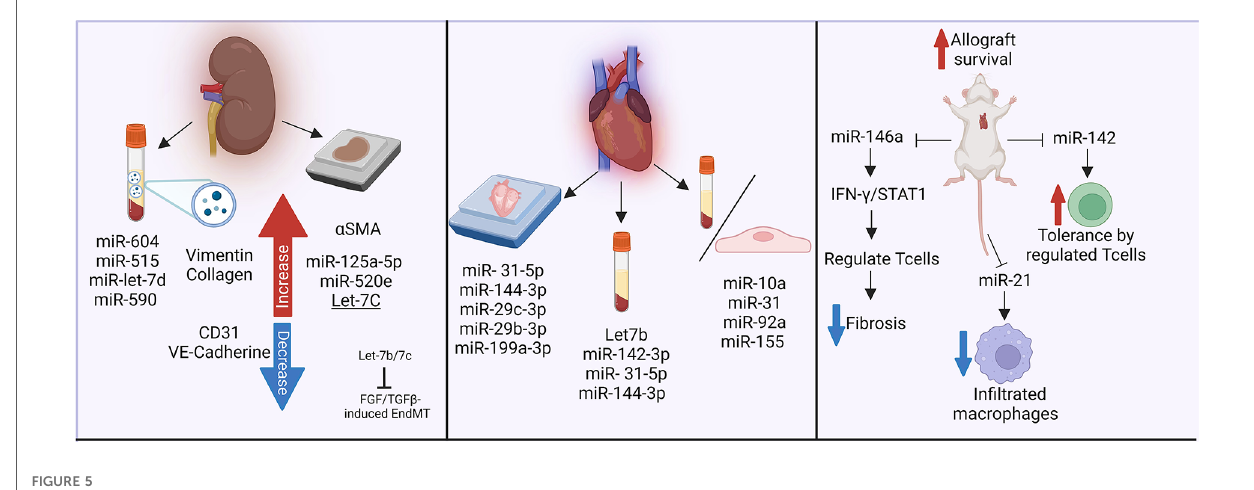
FIGURE 5 Non-coding RNAs in antibody-mediated rejection and transplant vasculopathy. The in fl uence of miRNAs in fi brotic pathways, complement regulation, in fl ammatory responses and rejection has been analyzed in biopsies and plasma samples from kidney and heart transplant recipients. Murine models have further described the impact of miR-146a and miR-142 in heart transplant survival. Made in